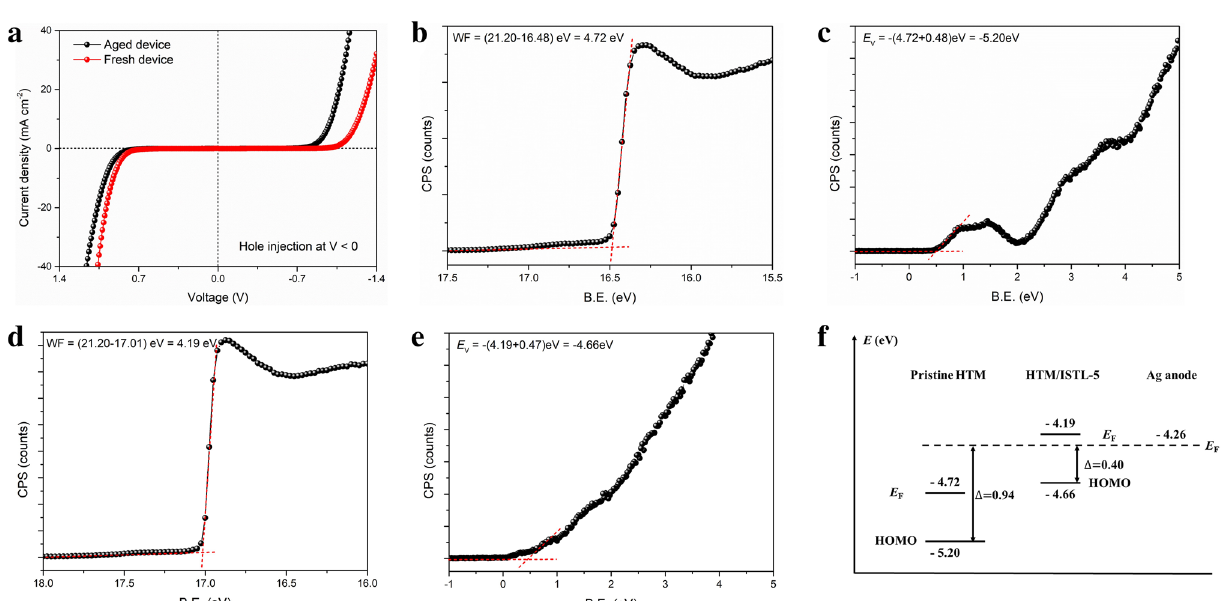
Fig. 2 Elimination of the Schottky barrier at HTM/Ag interface by naturally formed AgI tunneling layer. a The J–V characteristics under dark for the fresh Ag-PSCs and the aged Ag-PSCs after 24-h of storage. b, d The high binding energy cutoff region and c, e low binding-energy region of UPS results of spiro-OMeTAD b, c without or d, e with AgI. f The schematic of the change in the energy level. The aged Ag-PSCs in 2a and samples in 2b‑e were stored under dark and dry environment (< 10% RH)